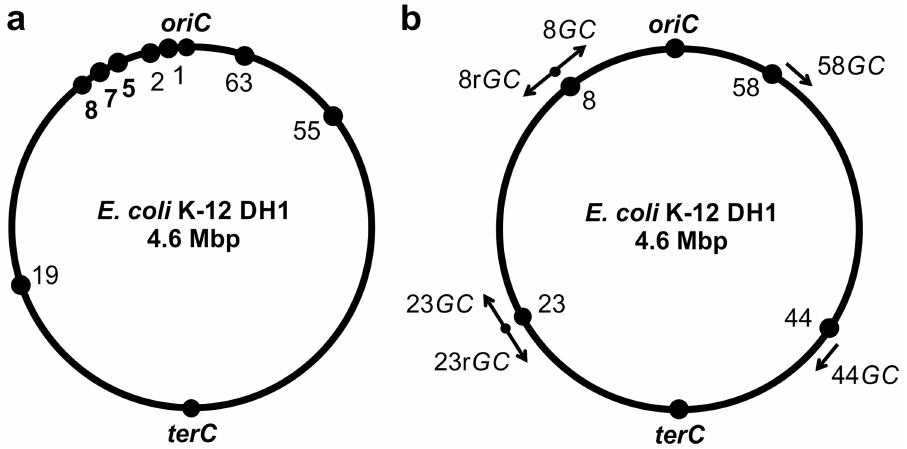
Fig 4. Chromosomal modification positions. (a) Eight nonessential regions were chosen for markerless deletion.(b) GC flux was integratedinto four positions,symmetrically distributedthroughout the genome.The arrows denote the direction of gene